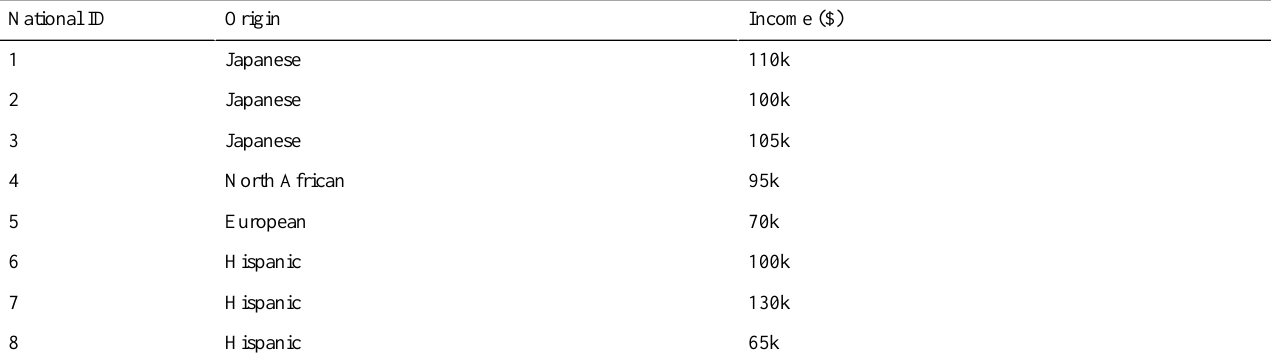
Table 1. Example of a population dataset, with one’s origin as the quasi-identifier and one’s income as the sensitive variable.